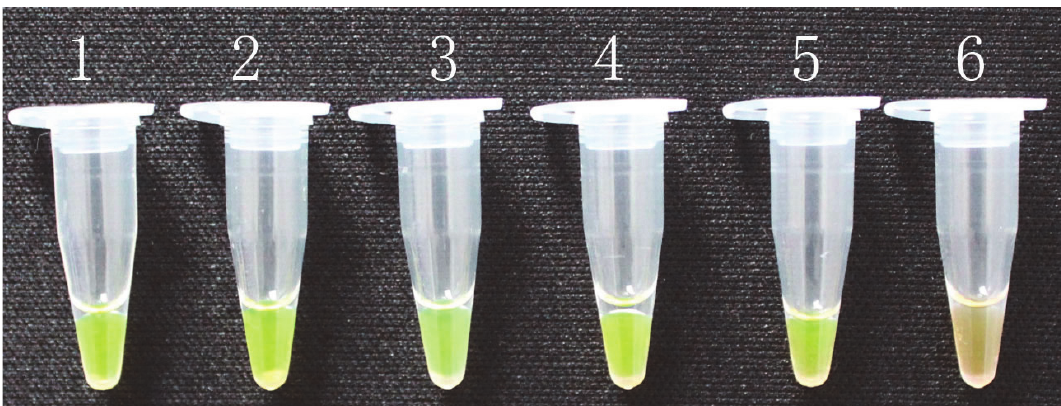
Figure 7: Direct testing of meat samples using LAMP assay. Tubes 1–6: meat mixtures of bovine meat were prepared with 50%, 10%, 5%, 1%, 0.5%, and 0.1% of raccoon dog meat, respectively. Amounts of raccoon dog component higher than 0.5% of the mixture were directly detected.